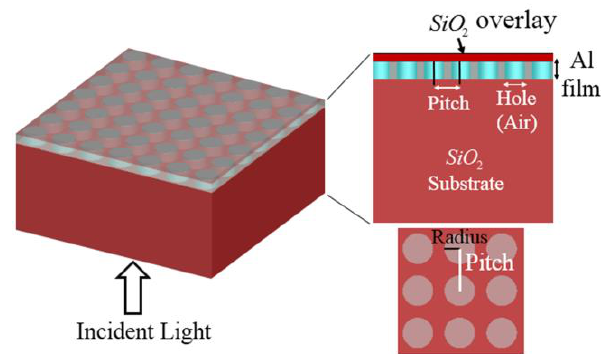
Figure 1. A schematic representation of our proposed nanohole array-based plasmonic color filters